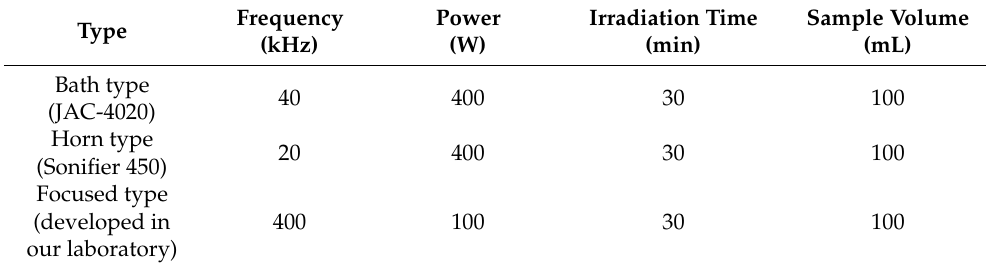
Table 2. Operating conditions for ultrasonic emulsification.